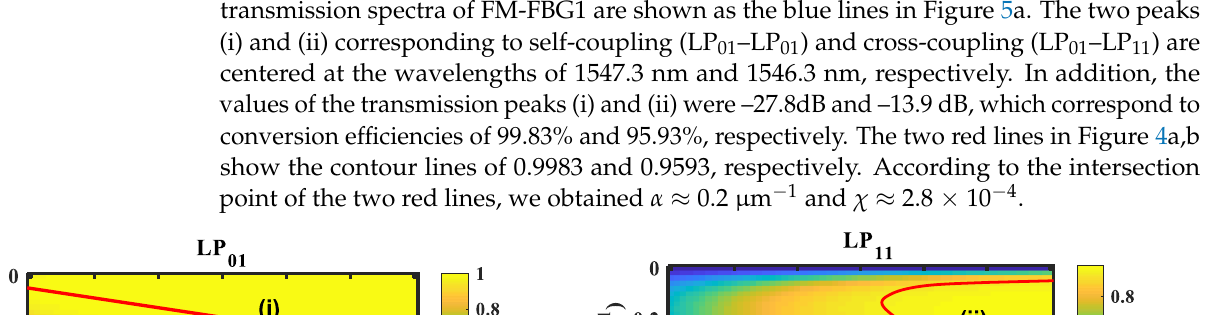
Figure 4. The conversion efficiencies of the ( a ) LP 01 mode and ( b ) LP 11 mode versus attenuation coefficient α and grating amplitude χ under LP 01 mode excitation (red lines ( i ) and ( ii ) are contour lines of 0.9983 and 0.9593, respectively).